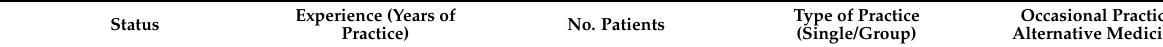
Table 2. Demographic factors and professional